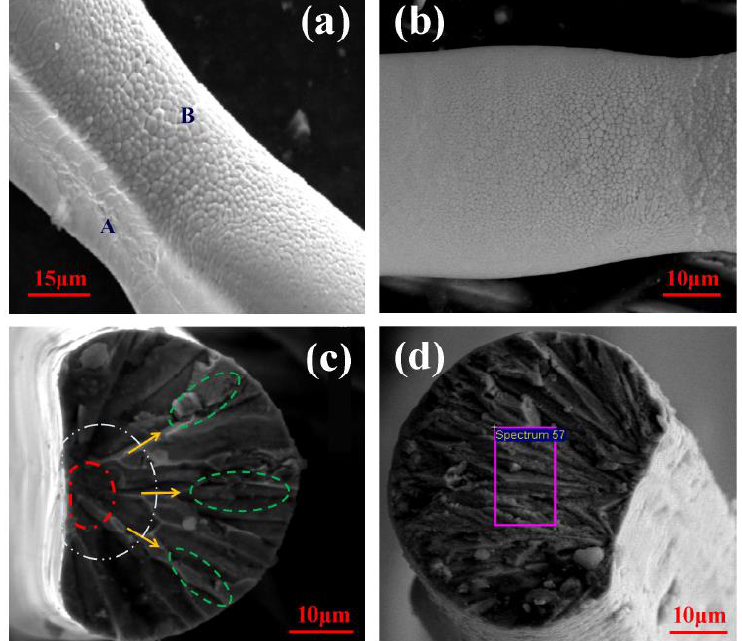
Figure 2. ( a ) Surface morphology of ordered heat-treated Ni-Mn-Ga microwires, ( b ) circular surface of ordered heat-treated Ni-Mn-Ga-Fe microwires, ( c ) fracture cross section of ordered heat-treated